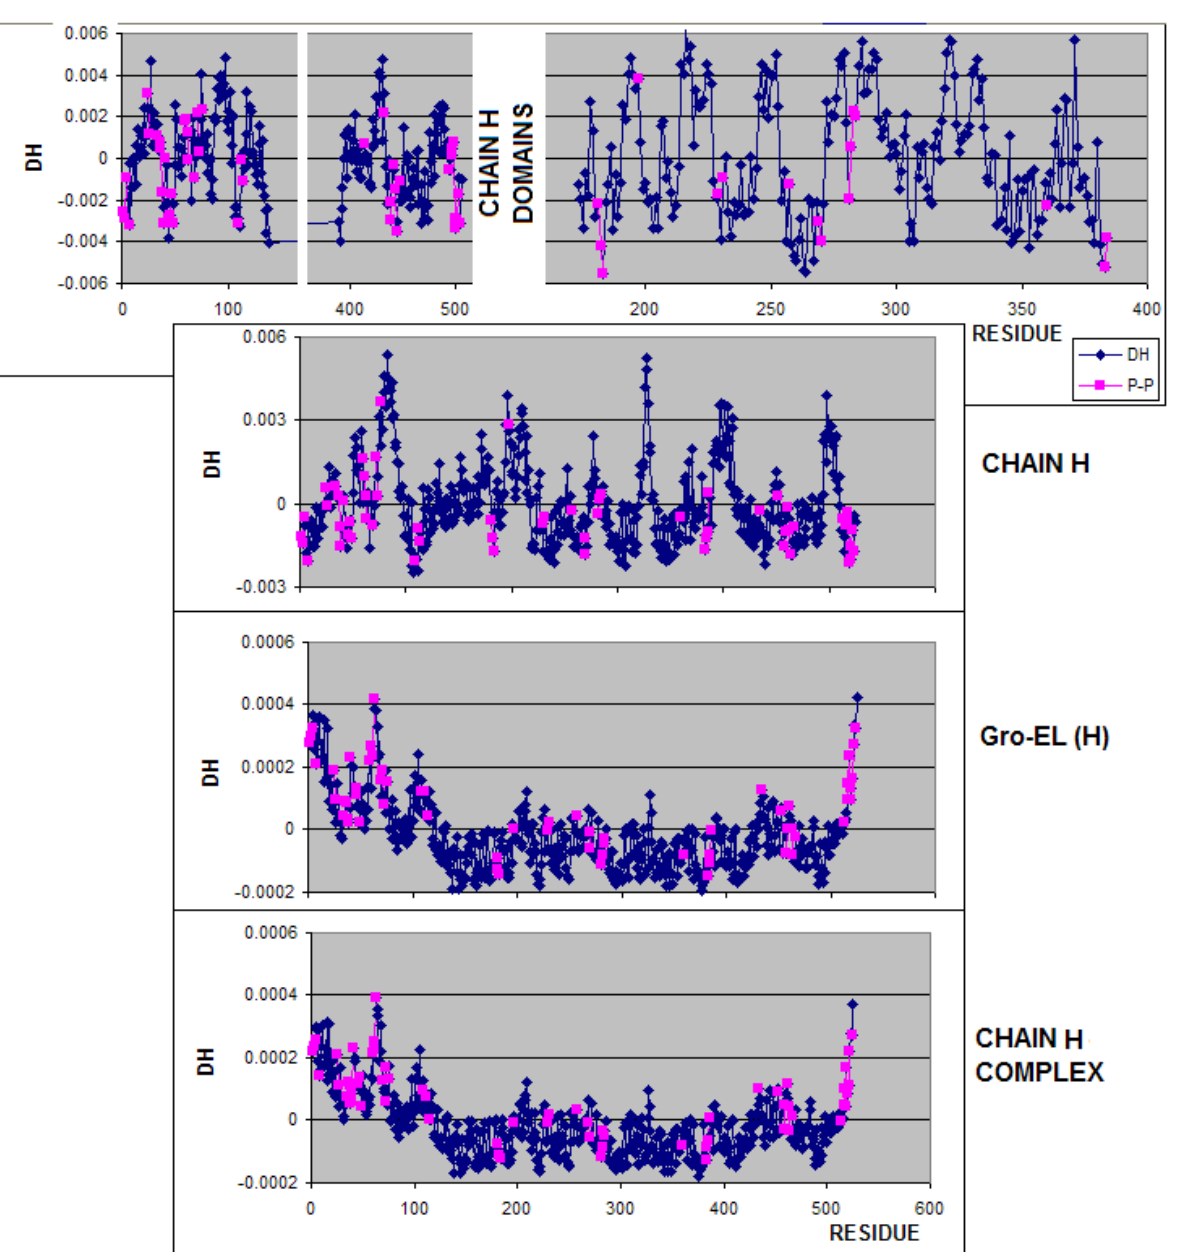
~ H Δ profile representing the irregularity of hydrophobicity density distribution in chain H calculated for units defined according to molecule partition: domains, chain, Gro-EL fragment and entire complex GroEL-GroES. The differences are the result of different orientation of chain H versus the oil drop